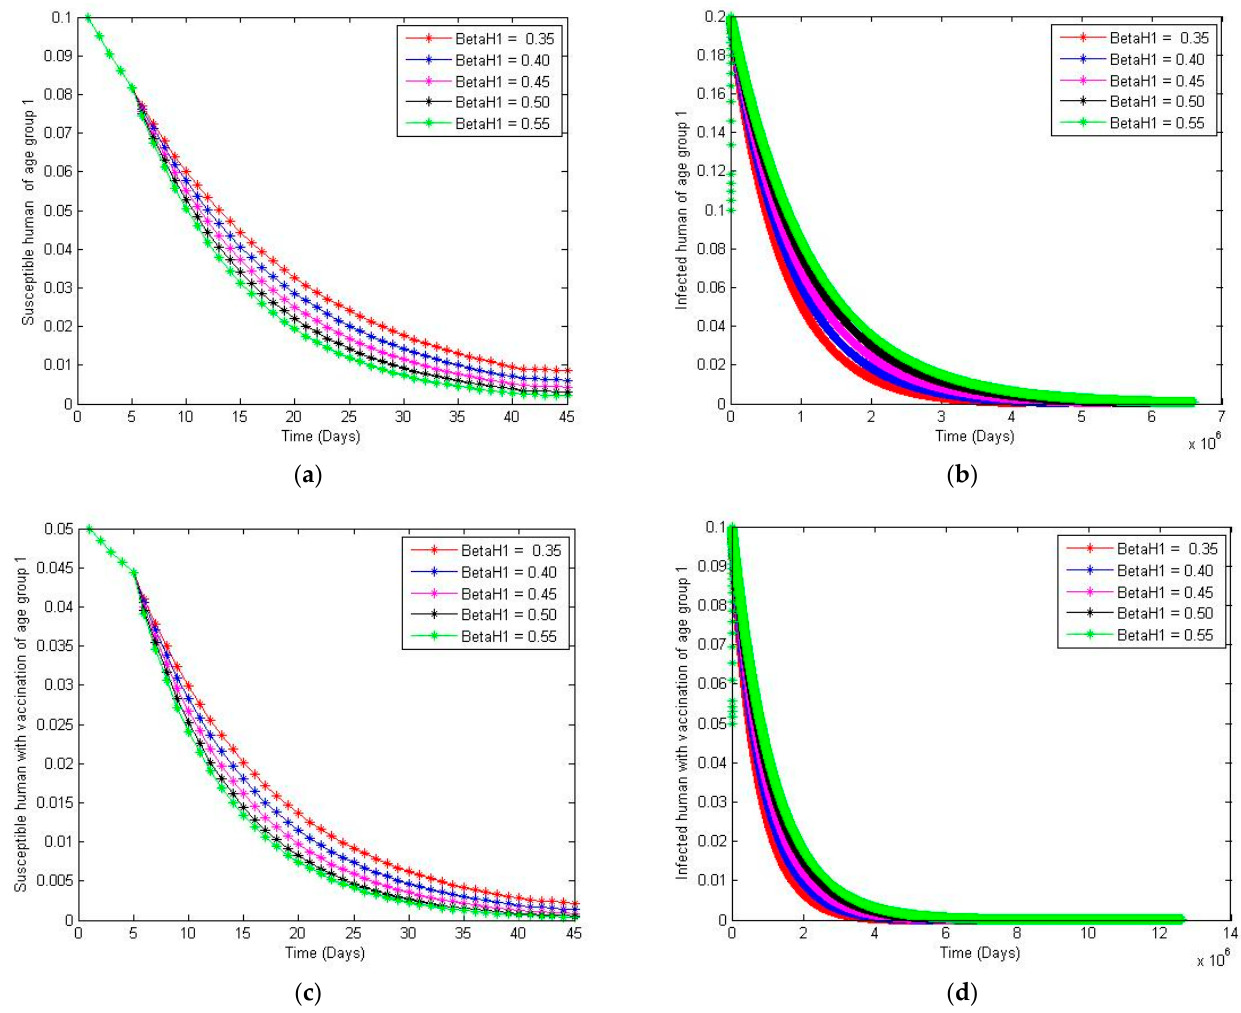
, I H , S H , and I H toward the endemic steady state, respectively. 1 1 1 V 1 V